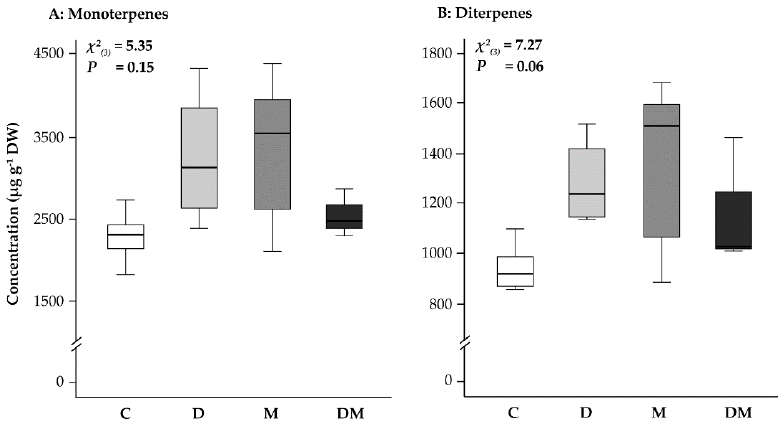
Figure 5. Effect of application of drought (D) and MeJA (M), separately and combined (D + M), on